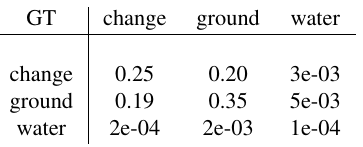
Table 1. conf Matrix preproz. 1m, enh 3m